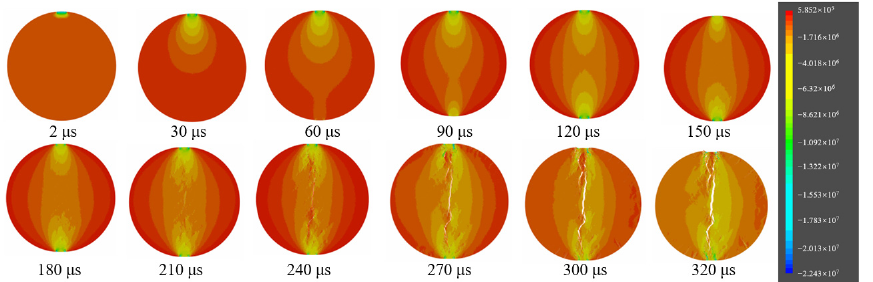
Figure 24. Dynamic splitting stress field evolution of a typical Brazil disk coal specimen under impact load.